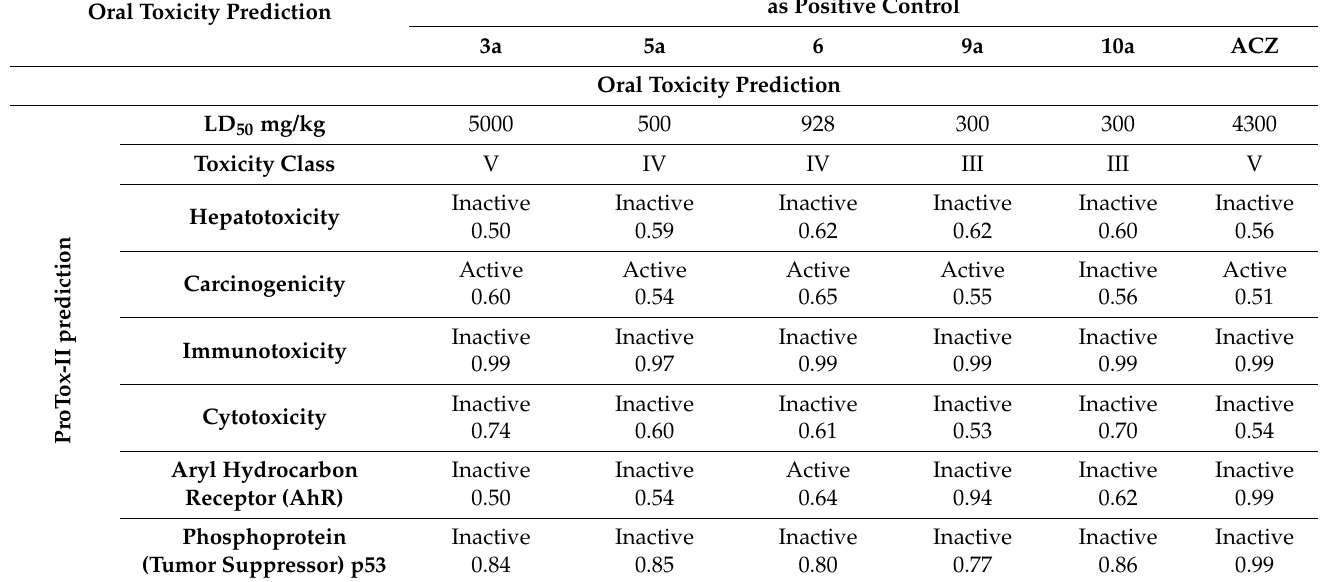
Table 7. In silico toxicity prediction of the most active pyrazole and pyrazolo[1,5- a ]pyrimidine derivatives compared with acetazolamide as positive